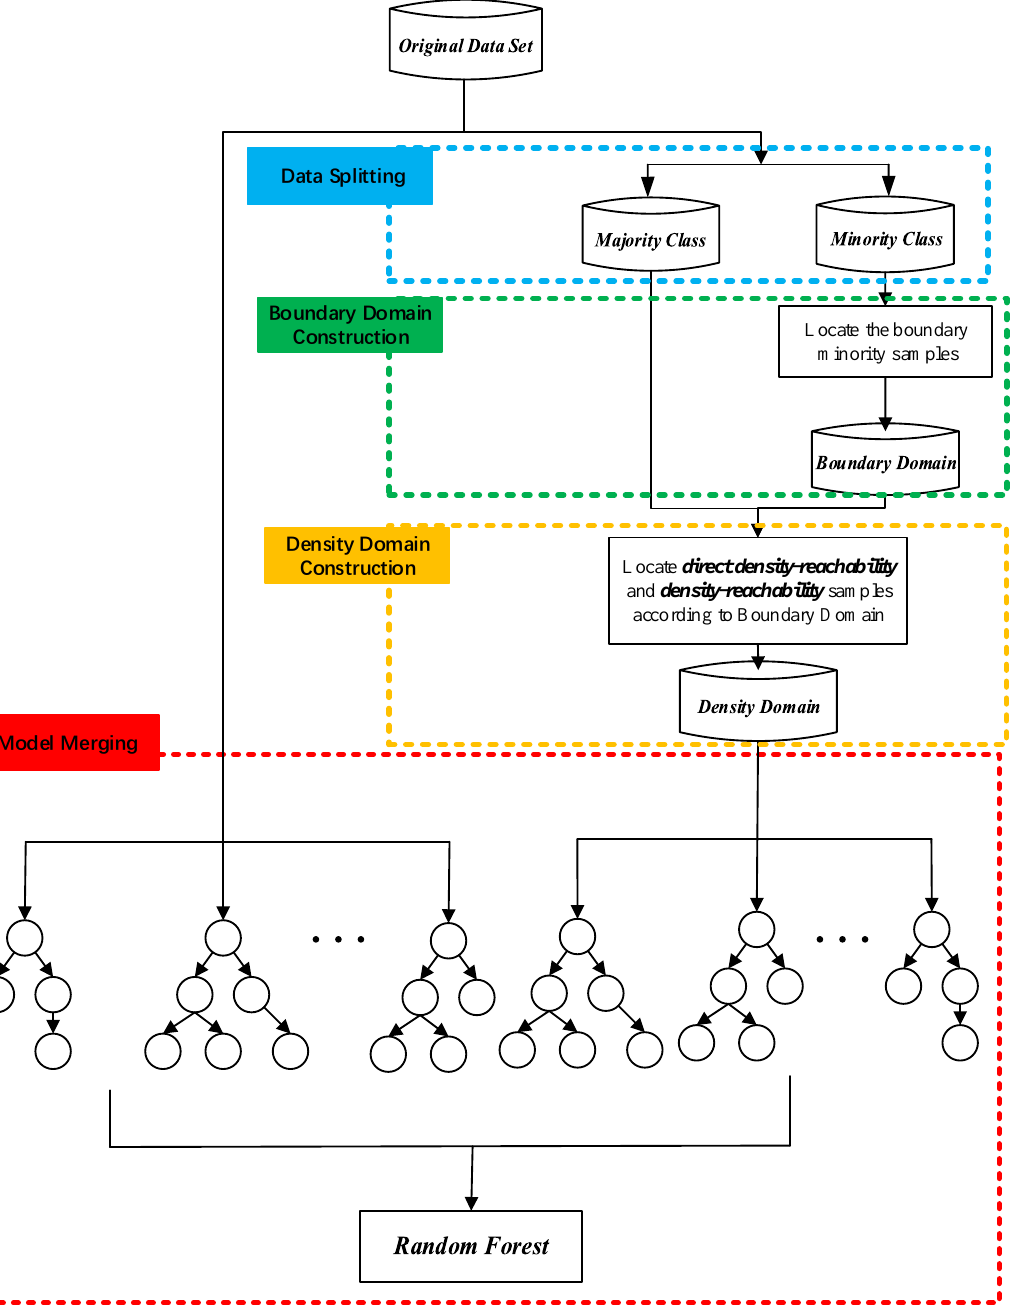
Figure 3. Framework of the density-based random forest (DBRF) algorithm. For data splitting, the original dataset was divided into majority and minority sets.